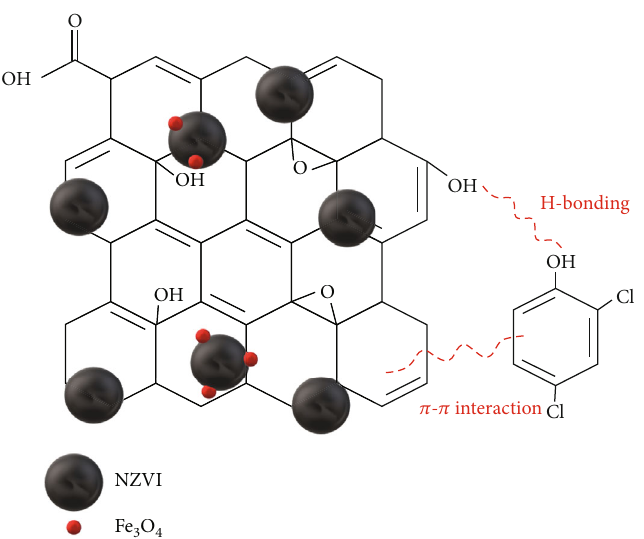
Figure 4: The possible removal mechanisms 2,4-DCP by